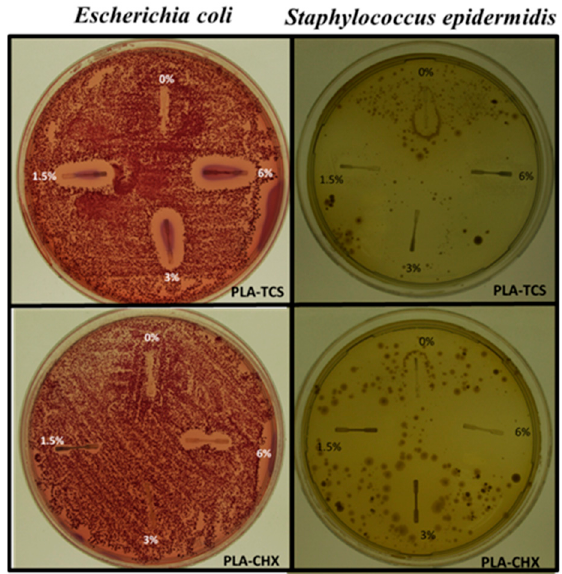
Figure 13. Agar tests performed with PLA samples loaded with 1.5 / 3 / 6 wt-% of each drug (TCS or CHX) for E. coli and S. epidermidis . For the sake of completeness, PLA unloaded samples are also evaluated.